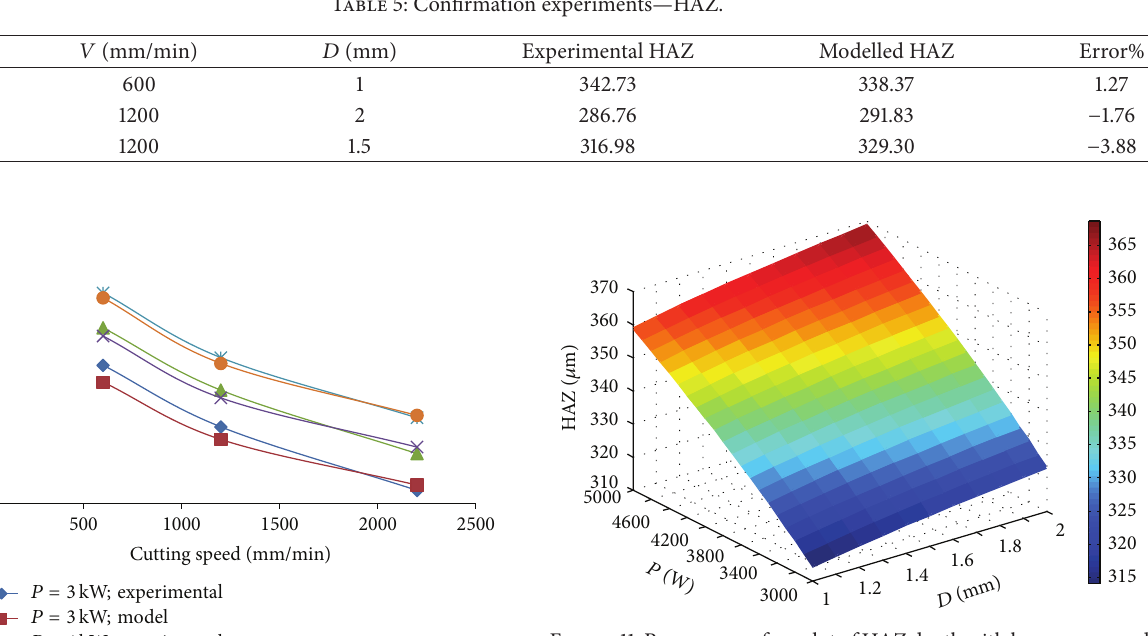
Figure 11: Response surface plot of HAZ depth with laser power and laser beam diameter ( 𝑉 = 6 00 mm/min).